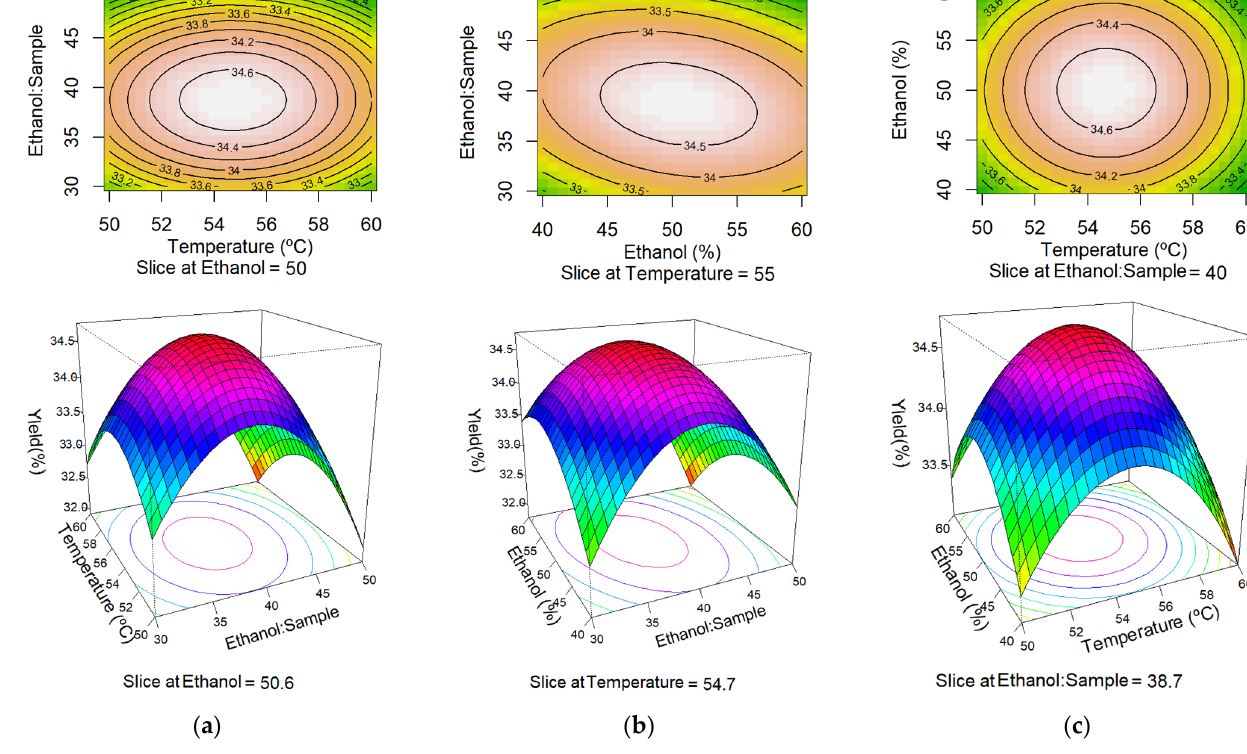
Figure 1. ( a ) The contour plot cut at the center point of ethanol = 50 and the response surface at the optimum maximum value of ethanol = 50.6 as a function of temperature and ethanol: sample. ( b ) The contour plot cut at the center point at temperature = 55 and the response surface at the optimum maximum value at temperature = 54.7 as a function of ethanol and ethanol: sample. ( c ) The contour plot cut at the center point of ethanol: sample (EA) = 40 and the response surface at the optimum maximum value for ethanol: sample = 38.7 as a function of ethanol and temperature. Table 2. Parameter estimates of the response surface model for estimating the yield (%) of extracts obtained from quinoa fermented by Monascus purpureus supplemented with fish hydrolysate and sodium chloride.